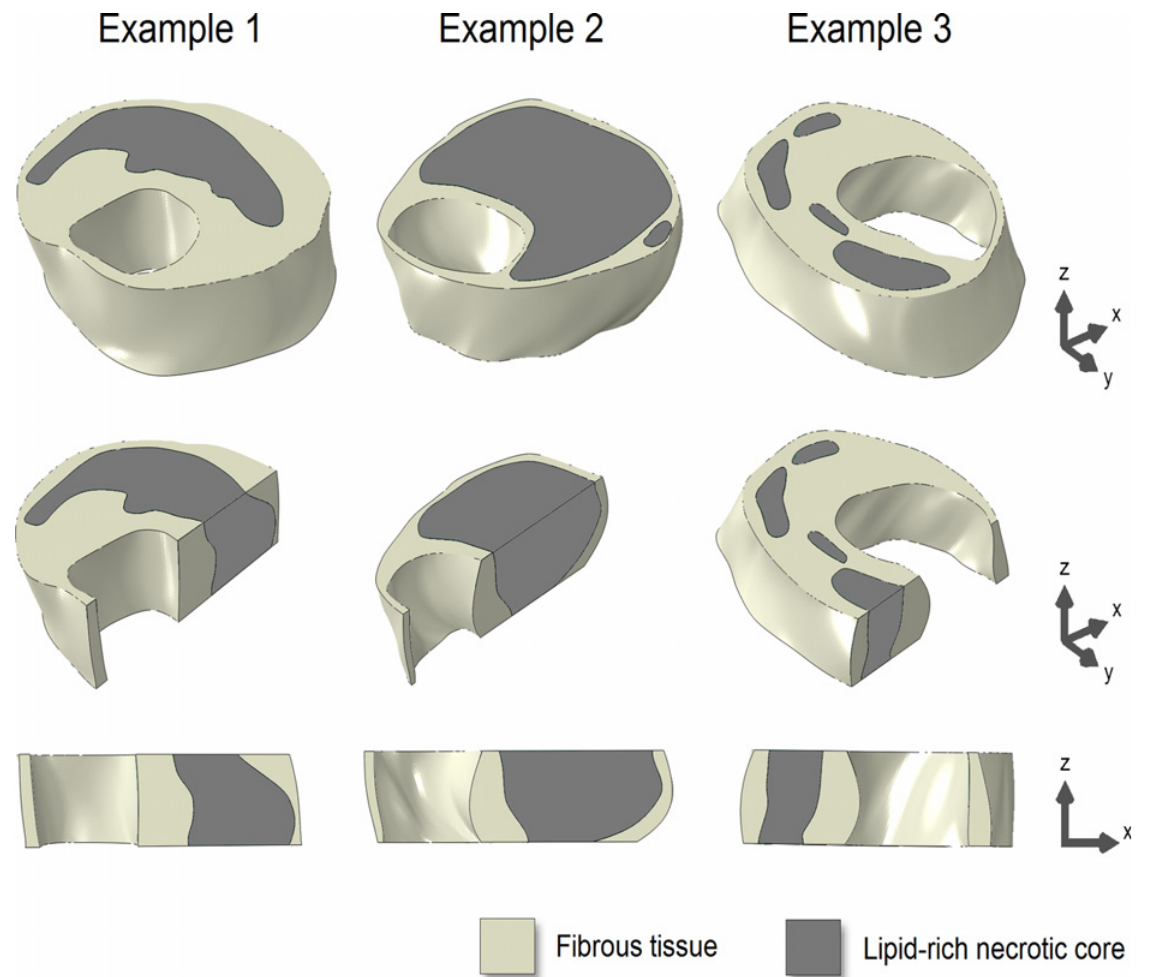
Fig 2. Three examples of the 3D ground truth plaque models (top row). Longitudinal cross-sectional views (middle and bottom rows) illustrate axial morphological variations.